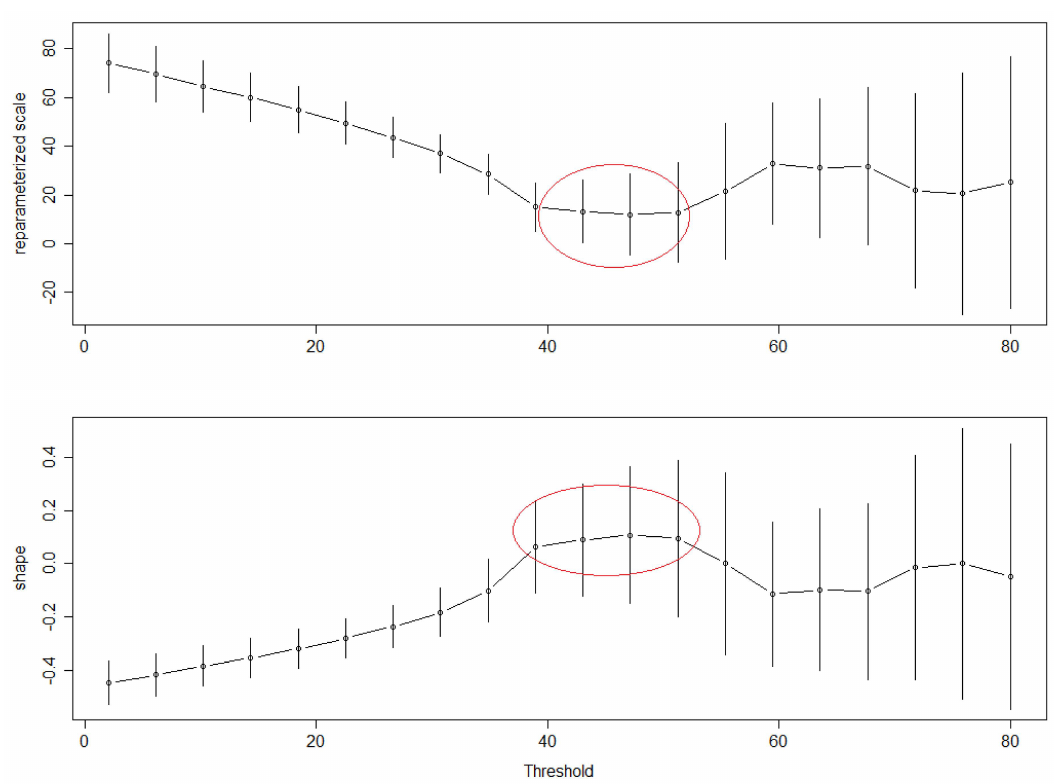
Figure A4. Parameter estimates against threshold for daily rainfall data at Kalalé